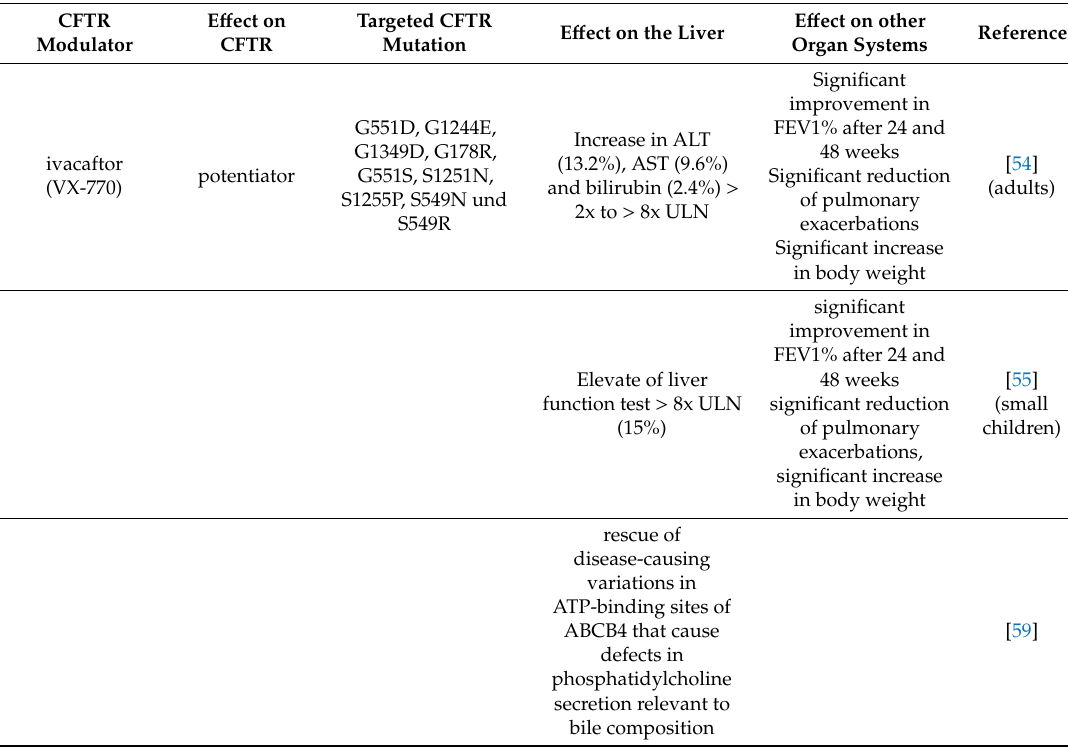
Table 2. E ff ects of approved Cystic Fibrosis Transmembrane Conductance Regulator modulators on Cystic Fibrosis organ